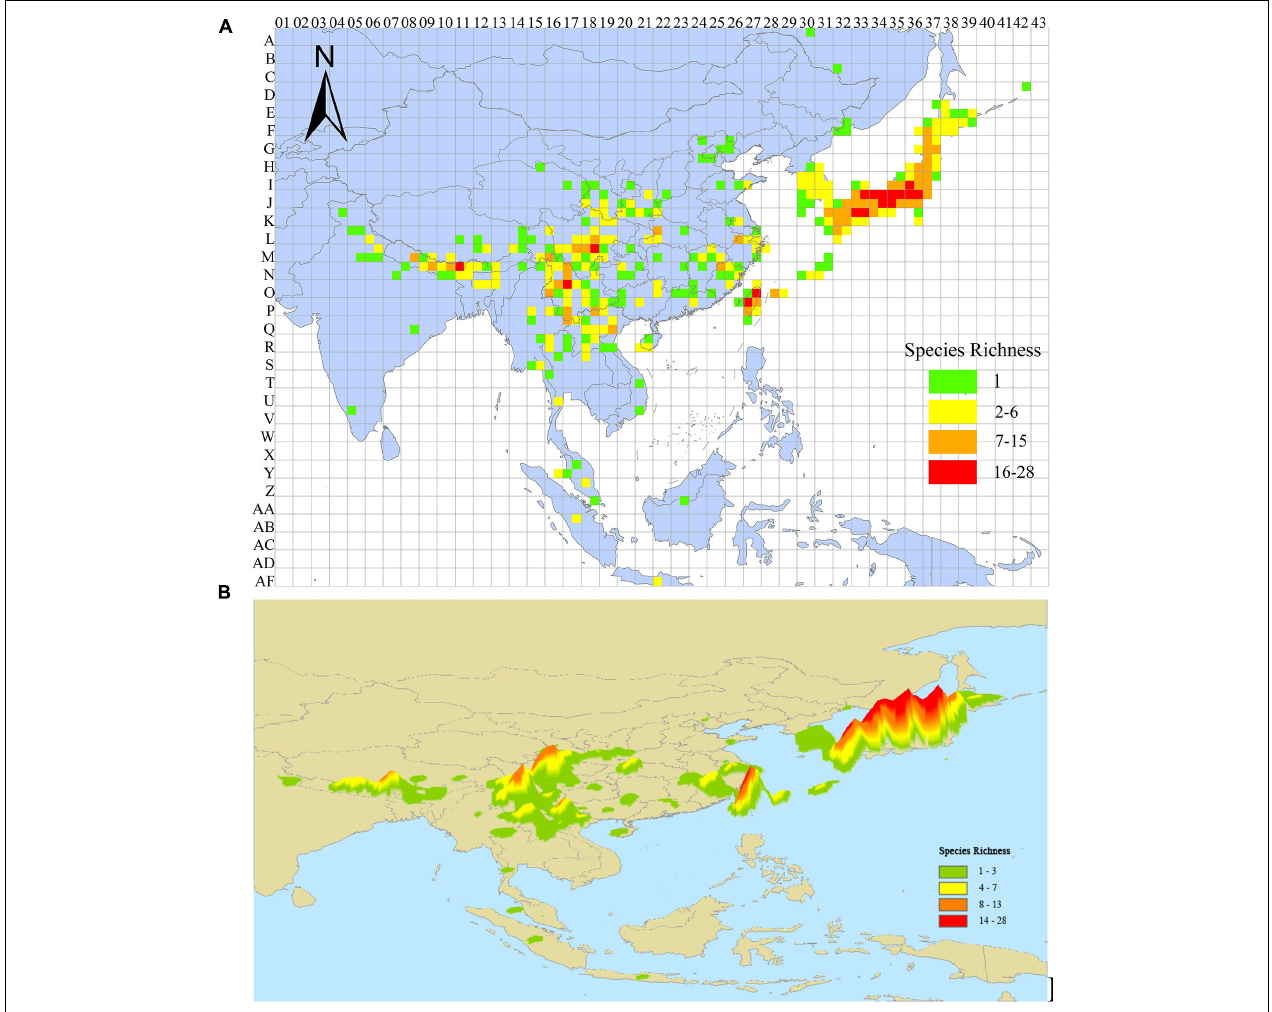
FIGURE 3 | (A) OGUs (quadrats) and labels used in PAE analysis, and the species richness pattern identified by 1 ◦ grid size. (B) Species richness patterns of Lycocerus under kernel density analysis.